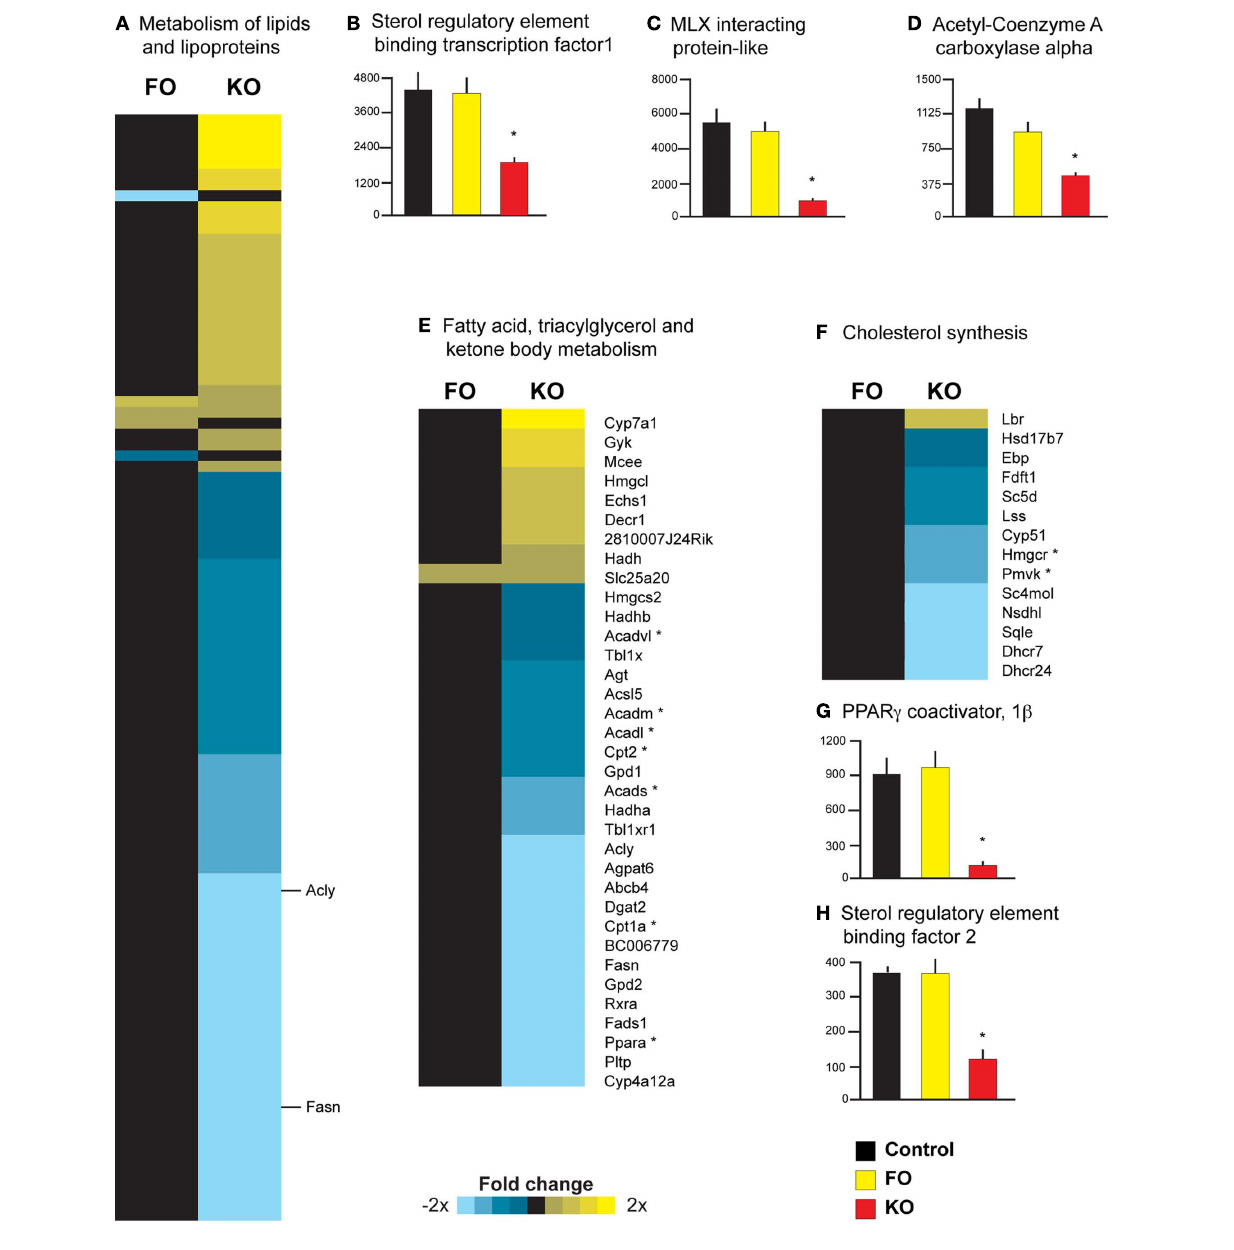
FIGURE 4 | Diverse effects of krill oil on genes regulating lipid metabolism in mouse liver. Pathway analysis revealed a significant downregulation by KO on the Reactome pathway “Metabolism of lipids and lipoproteins” (A) as well as three key transcriptional regulators of lipid metabolism, including Srebf1 (B) , Mlxipl (C) , and Acaca (D) . Individual gene symbols could not be represented for all genes in this pathway; two genes described in the Results section are highlighted with their respective gene symbols. In addition, KO downregulated the activity of the Reactome pathway significant ( p < 0.001) downregulation of these genes in the KO group ( − 7.9-fold change for Ppargc1b , Figure 4G and − 3.2-fold change for Srebf2 , Figure 4H ). Thus, these data support previous studies demonstrating that the liver is sensitive to the saturation of dietary fatty acids, and that PPARGC1B and SREBF2 activity may